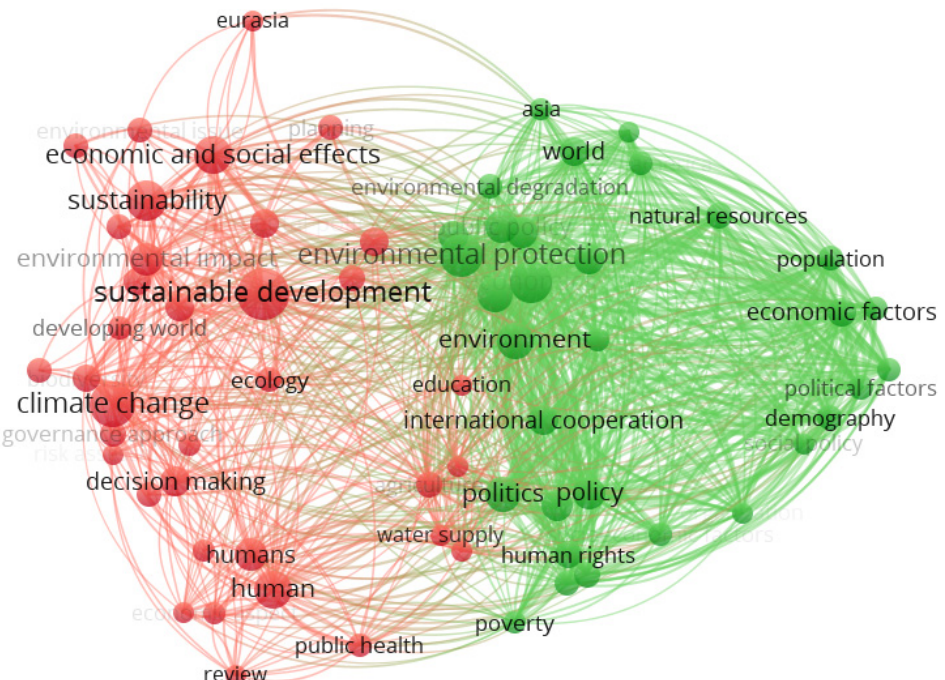
Figure 5. Co-citation analysis based on the cited authors.